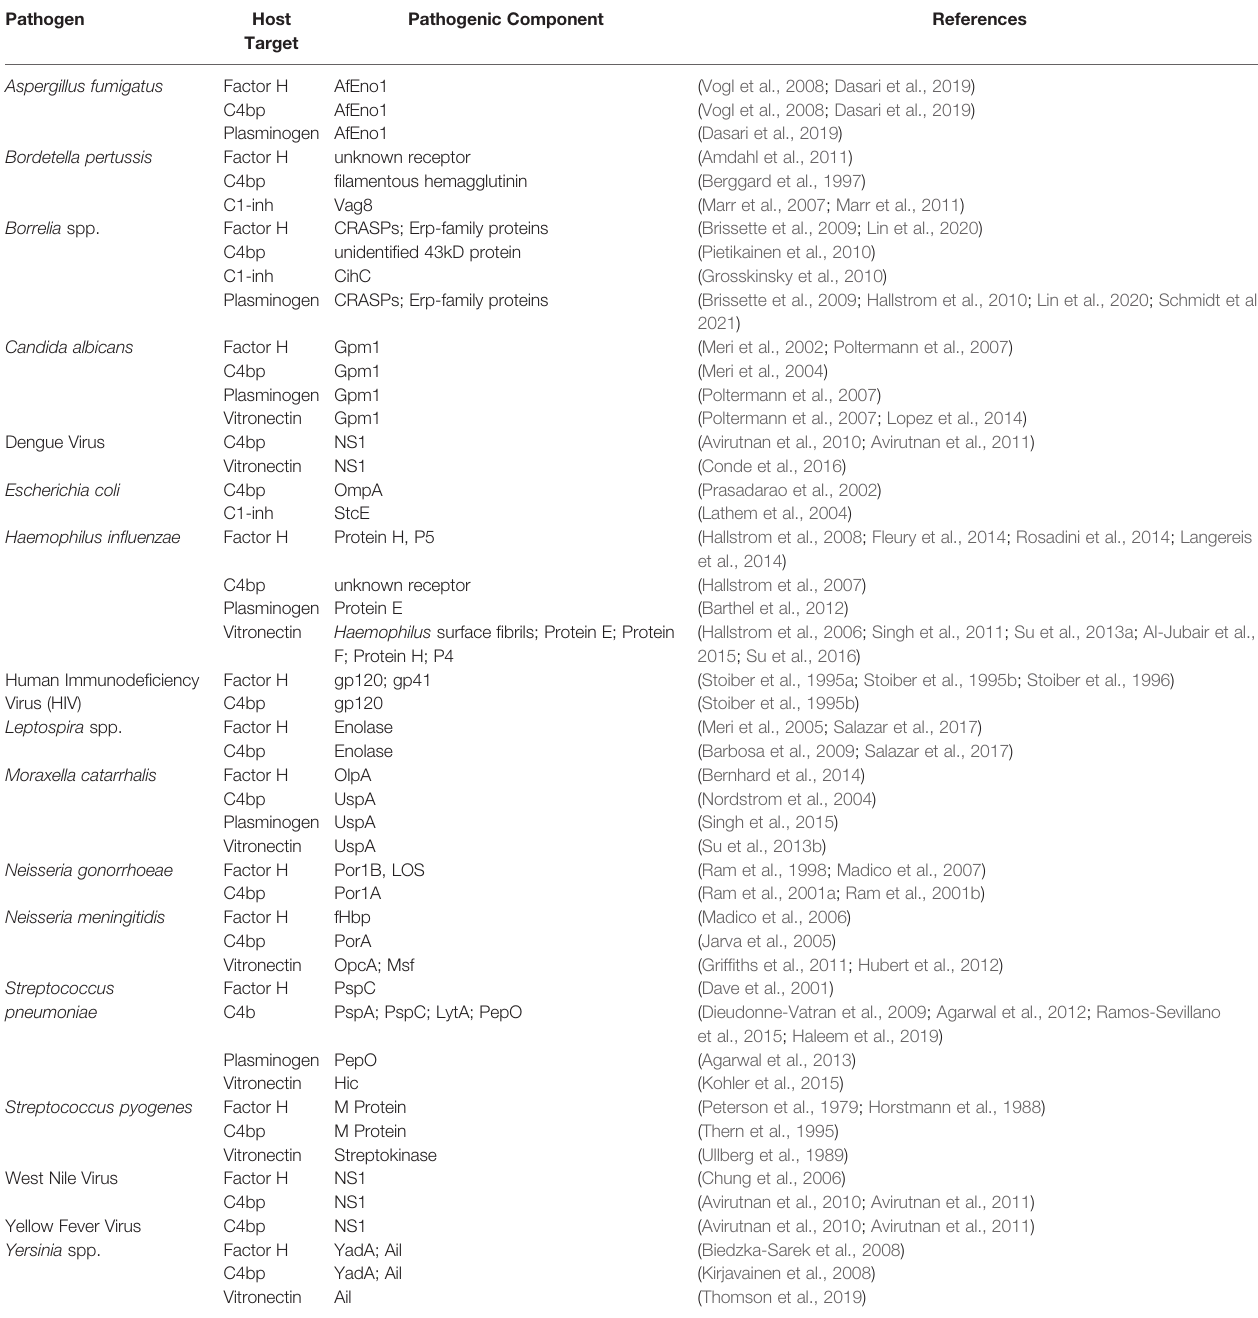
TABLE 1 | Abridged list of microbial receptors for complement regulatory proteins and their